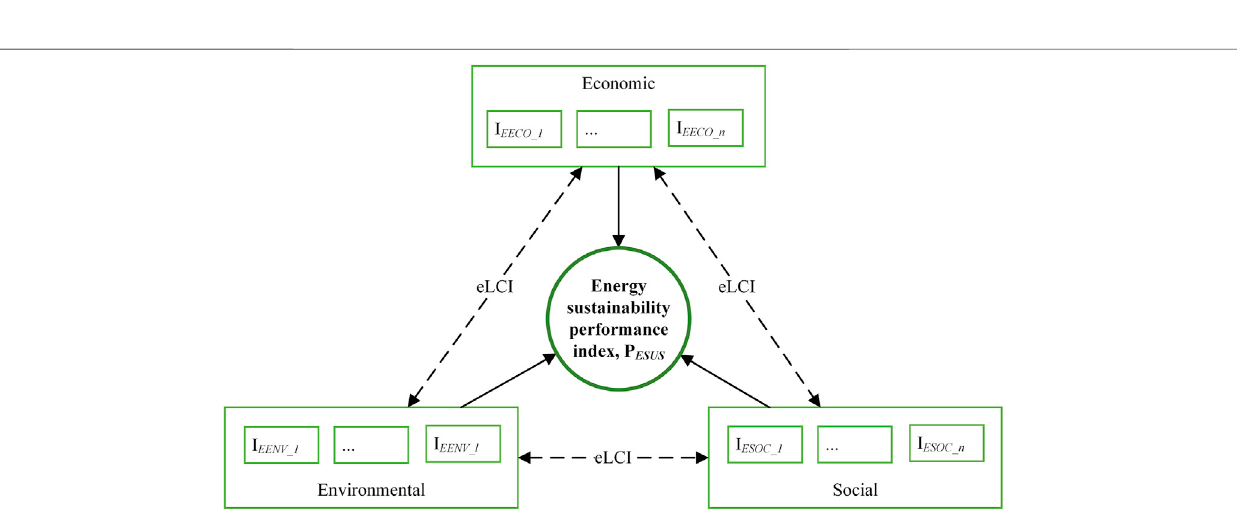
FIGURE 2 | Network of indicators within eLCI (own